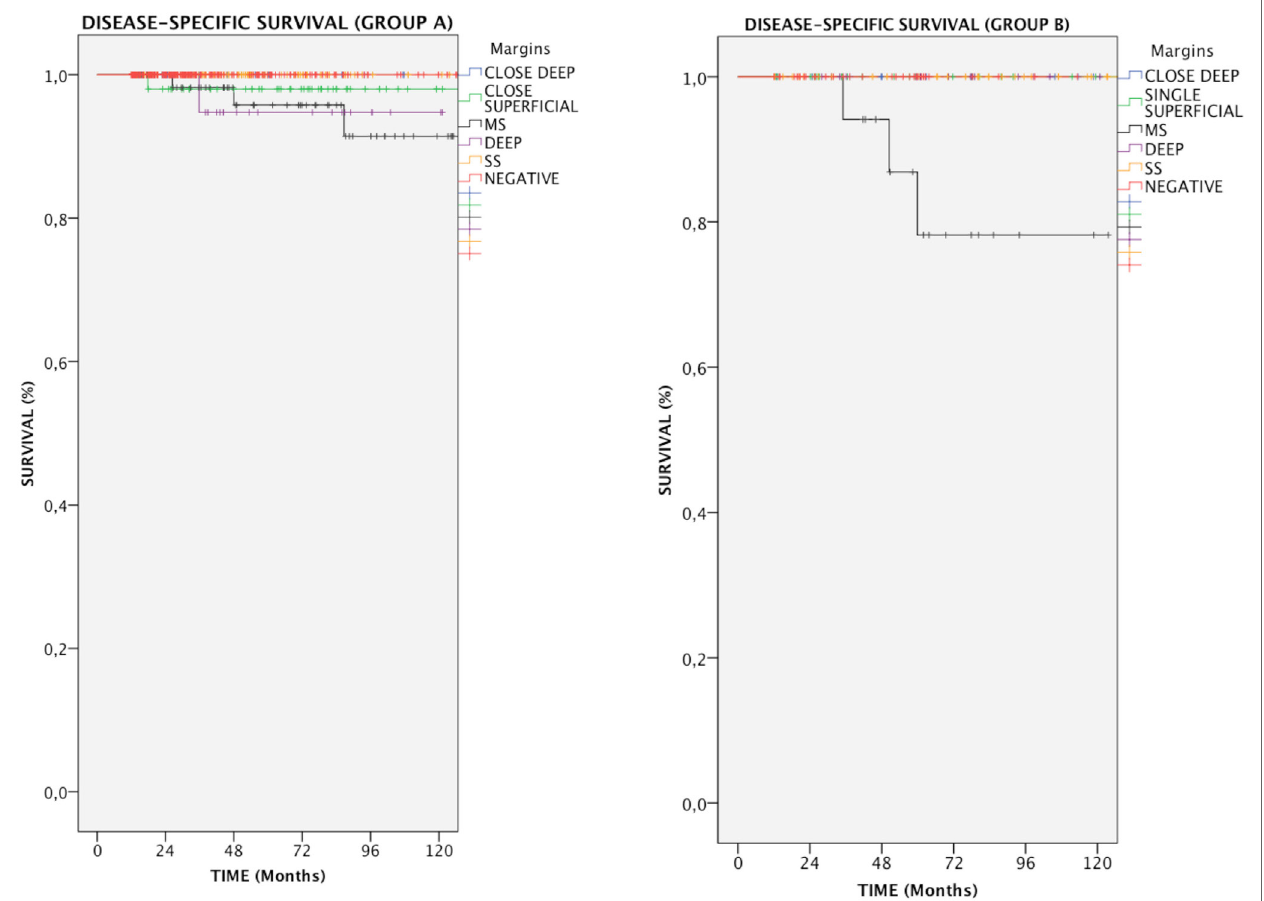
FigUre 2 | Kaplan–Meier curves showing disease-specific survival in relation to margin status for each group of patients. MS, positive multiple superficial margins; SS, positive single superficial margin; “ + ” symbol, censored